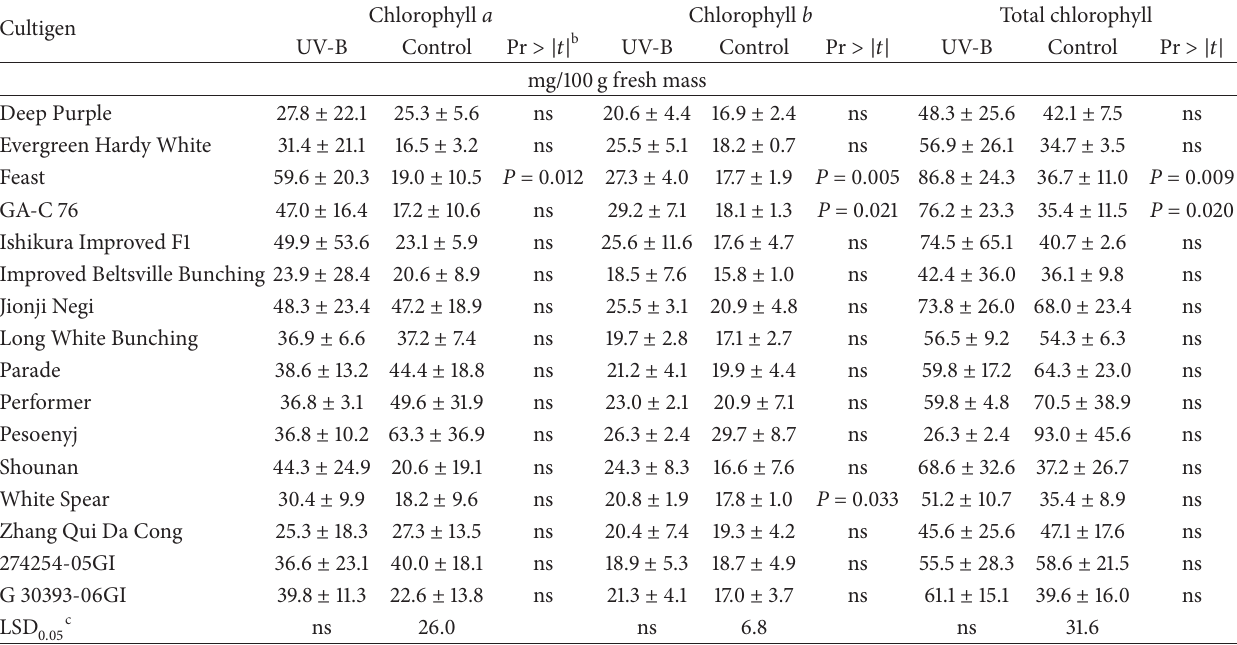
a Composition of 𝑛 = 6 plant samples from 4 replications ± standard deviation. b Significance based on paired Student’s t -test among treatments; ns: not significant. c LSD for differences between cultivar means 𝛼 = 0.05